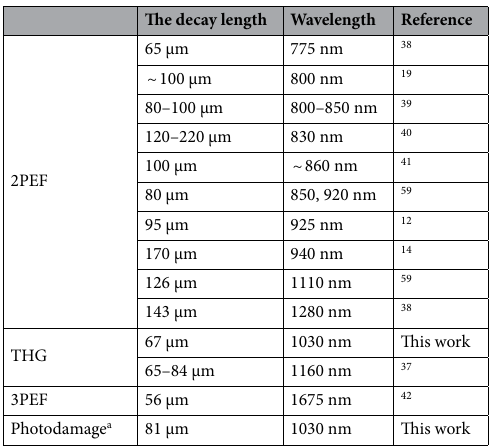
Table 2. The decay lengths of MPM imaging of the rodent brains. a The characteristic length at the excitation